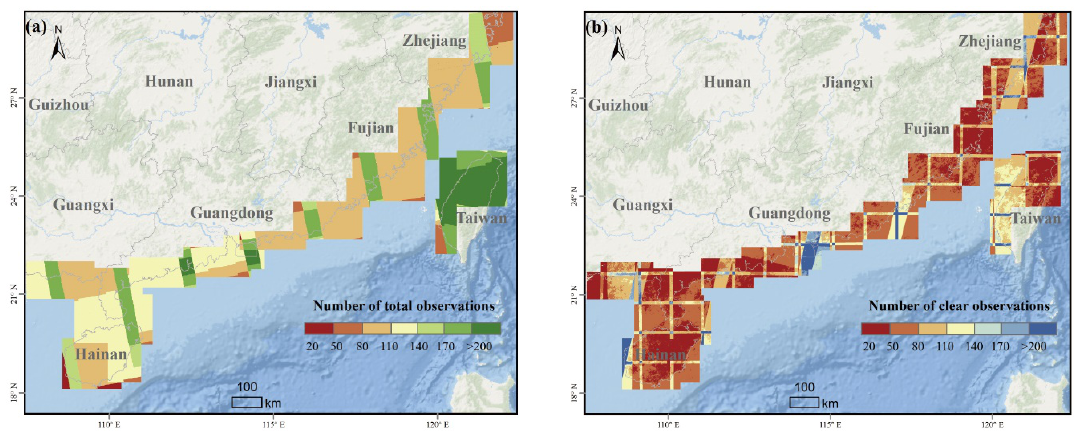
Figure 1. The study area and Sentinel-1/2 data used in this study: ( a ) the spatial distribution of total observation numbers for Sentinel-1 data covering the study area; ( b ) the spatial distribution of clear observation numbers for Sentinel-2 data covering the study area.